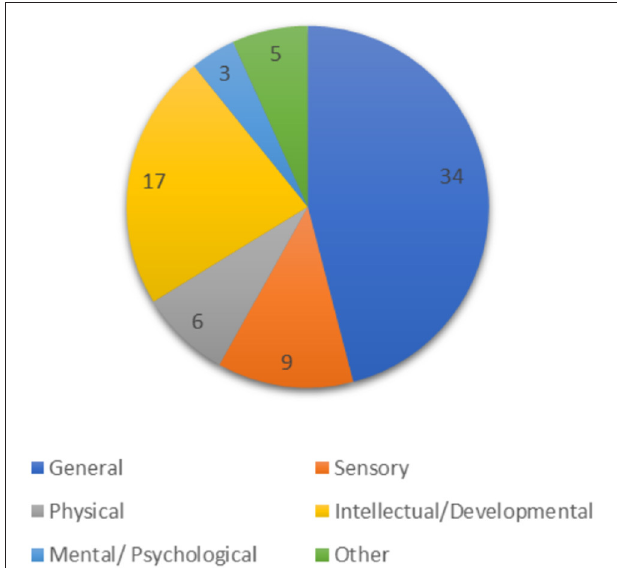
FIGURE 4 | Publications per disability type.